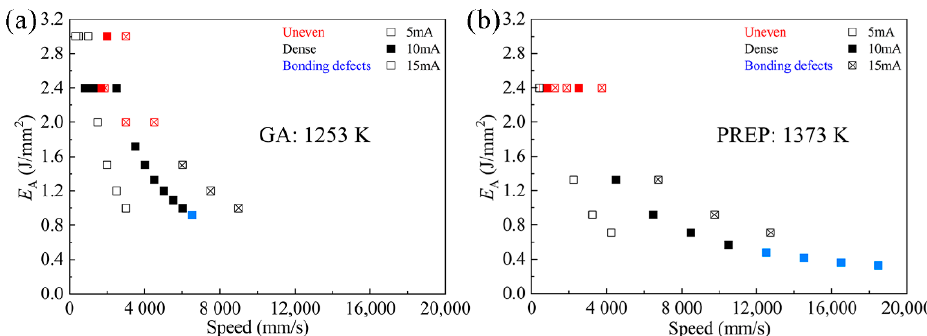
Figure 5. EBM processing windows for ( a ) GA powder and ( b ) PREP powder are plotted with scanning speed ( v ) against E A . Suitable parameters (combinations of beam current, scanning speed, and E A ) for dense samples with no top surface unevenness and binding defects are indicated by black symbols.